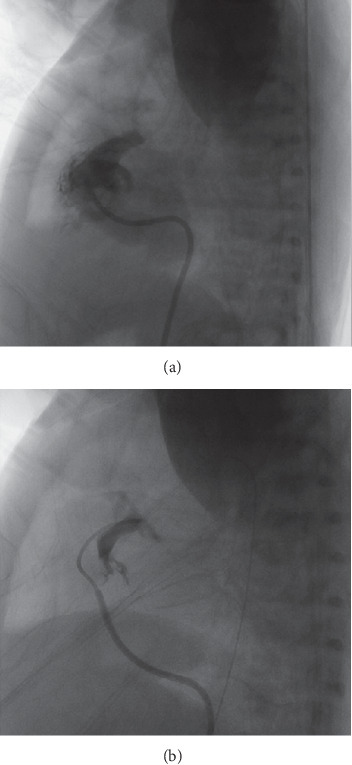
(a) Angiography of the atretic pulmonary valve with the Simmons catheter (lateral view). (b) Angiography with a microcatheter to confirm its position at the center of the pulmonary valve.